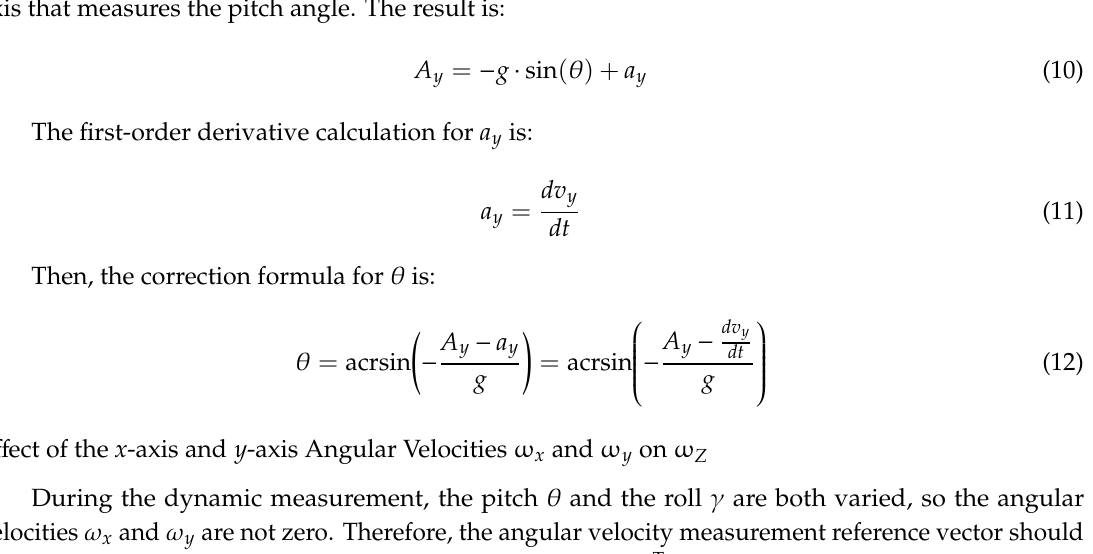
E ff ect of the y -axis Acceleration on the Pitch